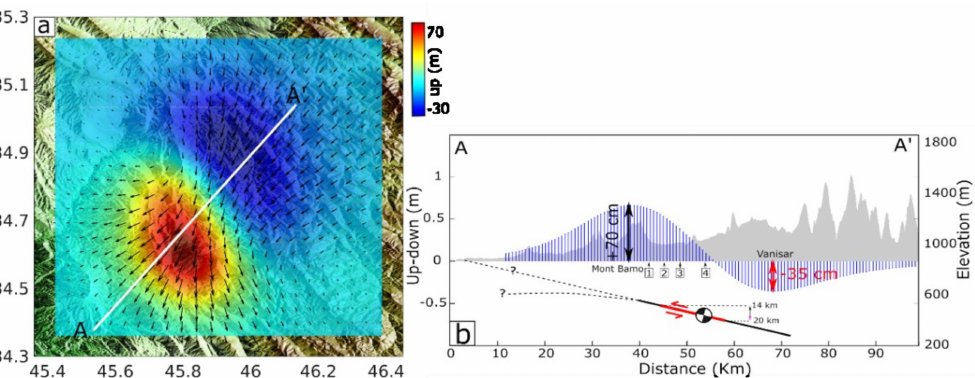
Figure 8. ( a ) Three-dimensional (3D) surface deformation field of the 2017 Sarpol-e Zahab earthquake estimated from the distributed slip model in Figure 5a. ( b ) Vertical ground motion along profile AA’ in ( a ) with the shaded region representing topography variation along the profile (scale on the right axis); the beach ball represents the cross-sectional view of the focal mechanism of the 2017 Sarpol-e Zahab earthquake, and the red region represents the slip at depth.